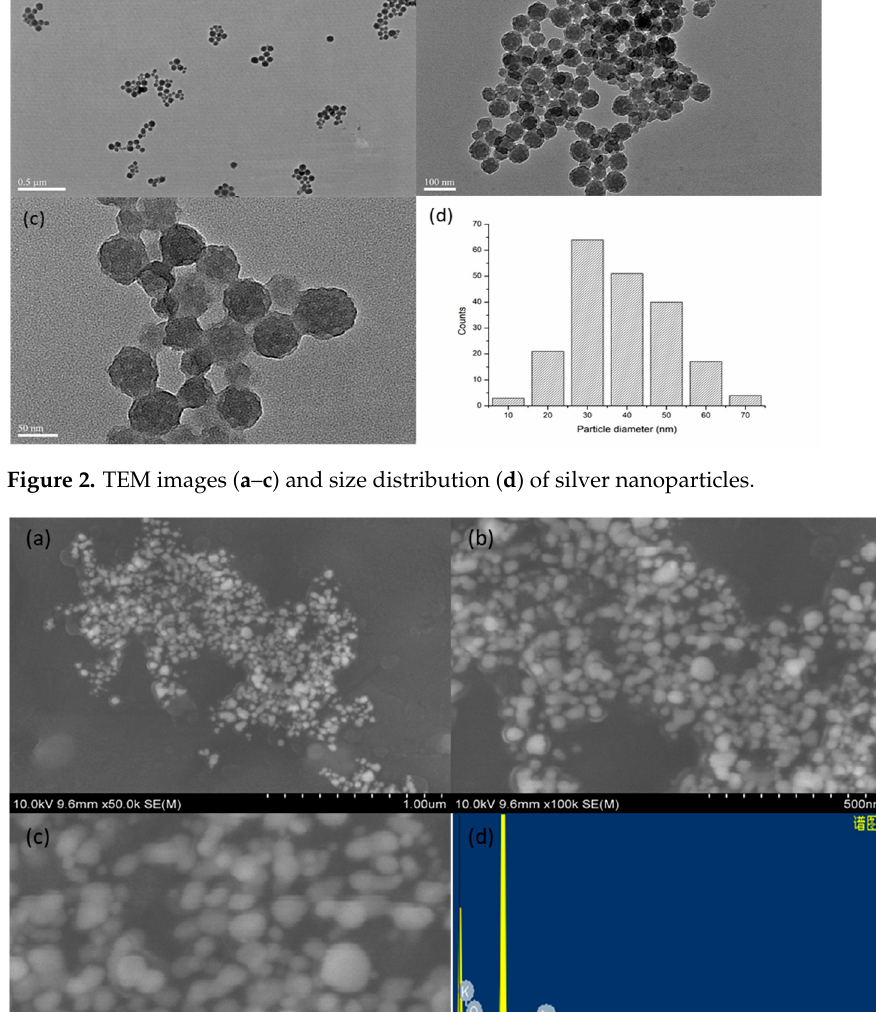
Figure 3. SEM images ( a – c ) and EDX spectrum ( d ) of silver nanoparticles.